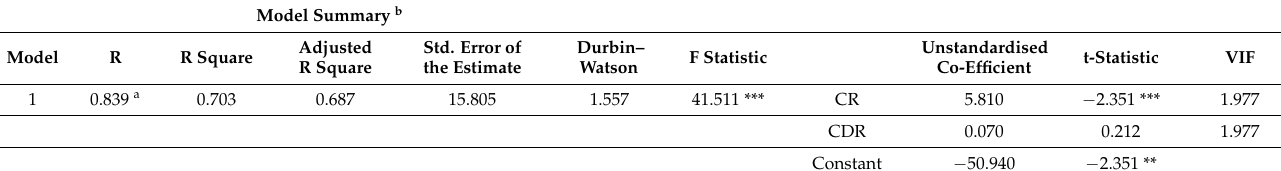
Table A14. Regression Model.